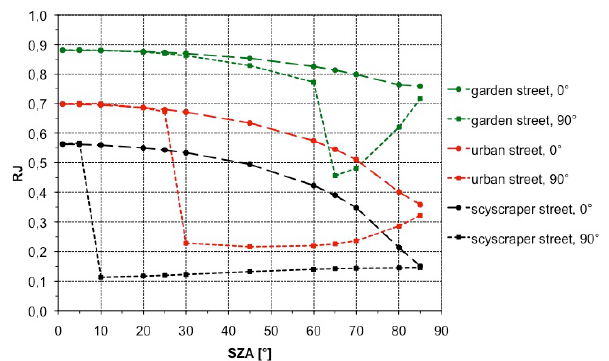
Fig. 7. Ratio RJ of NO 2 photolysis frequency in a street canyon and for undisturbed conditions as function of solar zenith angle. for a cloud-free atmosphere with low and with high turbidity and for a cloud obscuring the sun for an urban street with orientation parallel ( ϕ =0 ◦ ) and perpendicular to the sun ( ϕ =90 ◦